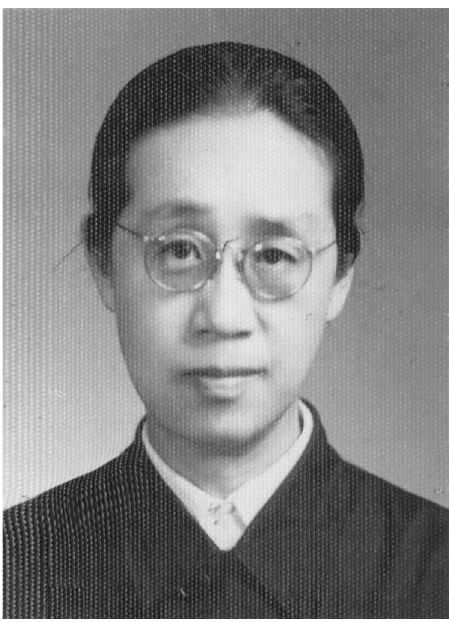
Figure 1. ProfessorWeisunTao(Feb.20,1895 – Dec.11,1982).